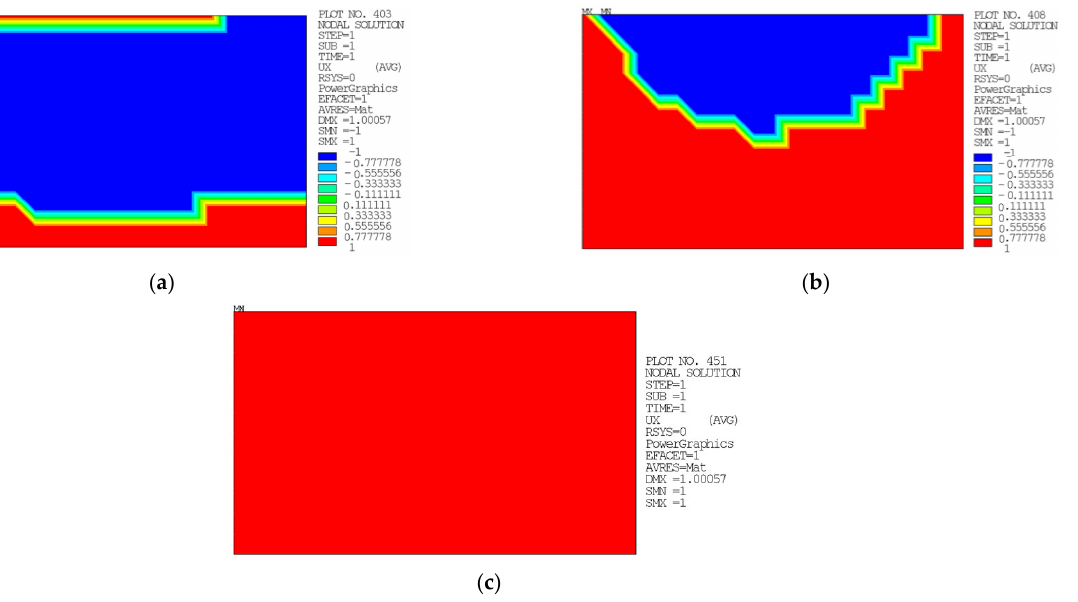
Figure 6. FEs in the elastic behavior state and their evolution to plastic behavior at ( a ) 13.93, ( b ) 682.57, and ( c ) 1379.07 days. ( b ) 682.57, and ( c ) 1379.07